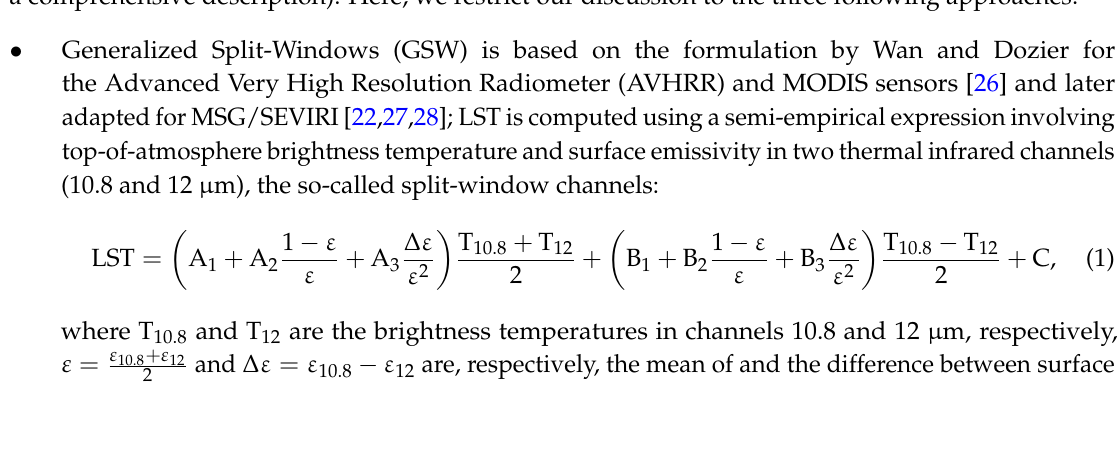
Figure 3. Map of orographic differences between ERA-Int and COSMO for the studied area.